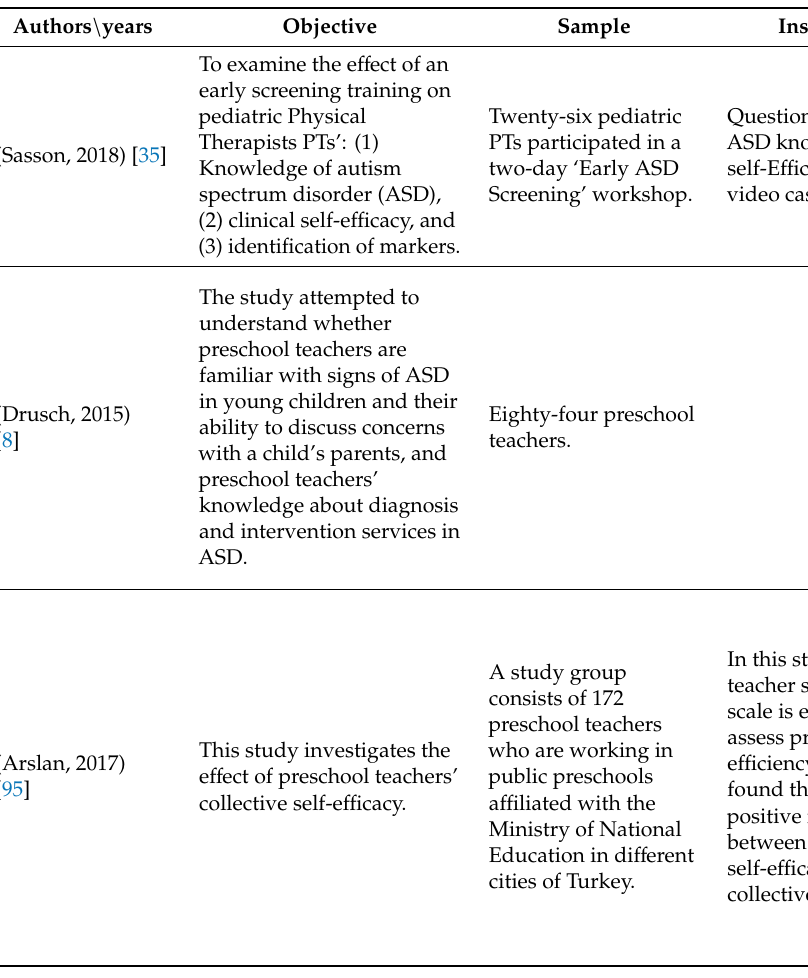
Table 4. Summary studies of self-e ffi cacy about